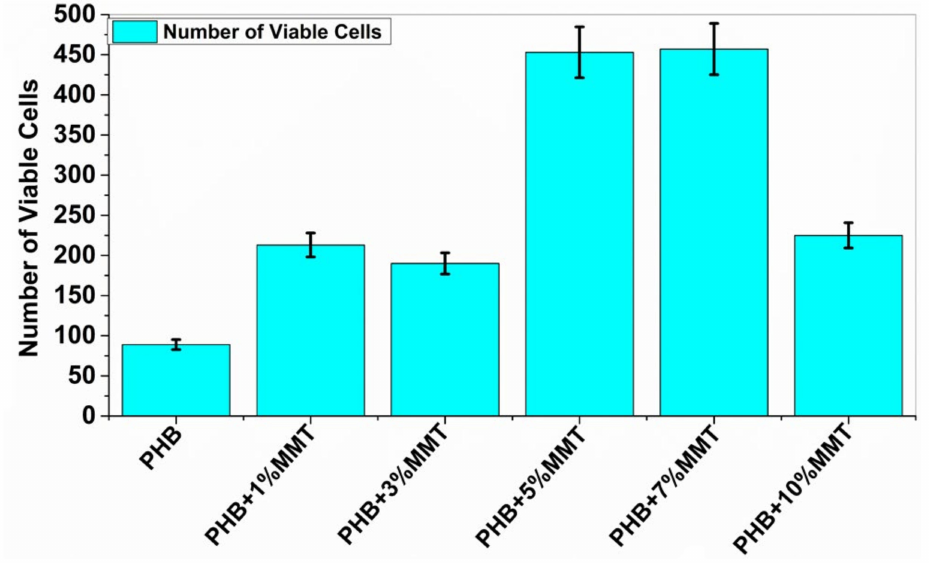
Figure 8. Increasing concentration of PHB + OMMT vs. no. of viable bacterial cells after 10 days of